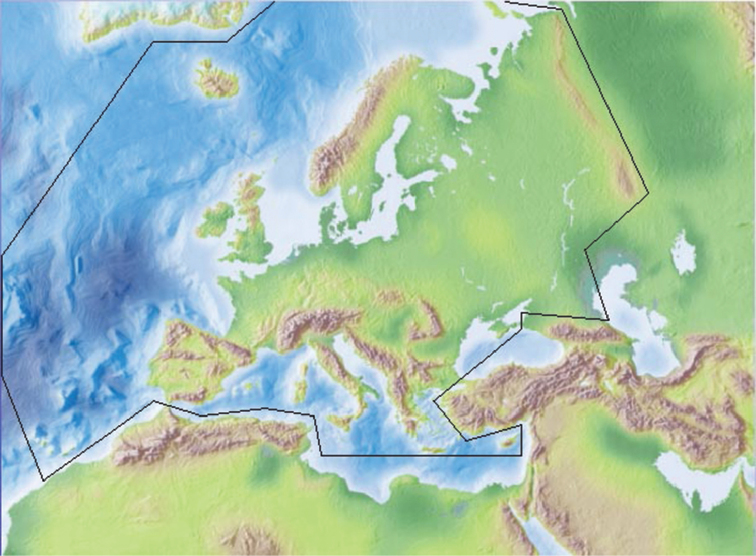
Boundaries of Europe according to Fauna Europaea (from de Jong et al. 2014).